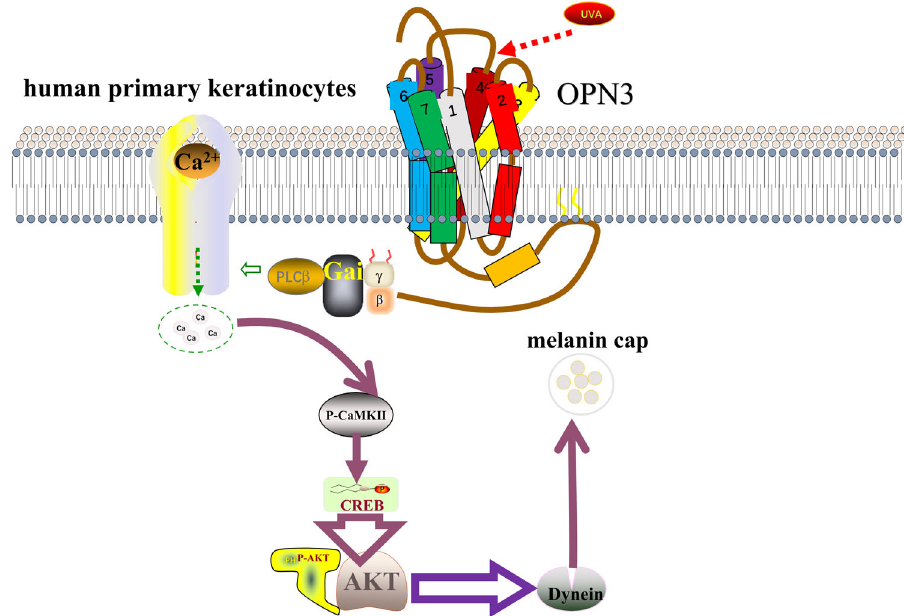
Fig. 8 Summary model of the key fi ndings in this study. OPN3 upregulates expression of Dync1i1 and DCTN1 in keratinocytes after UVA radiation exposure via the calcium-dependent G protein-coupled and Akt signaling pathway. (This fi gure was created based on the elements in the Science Slides software